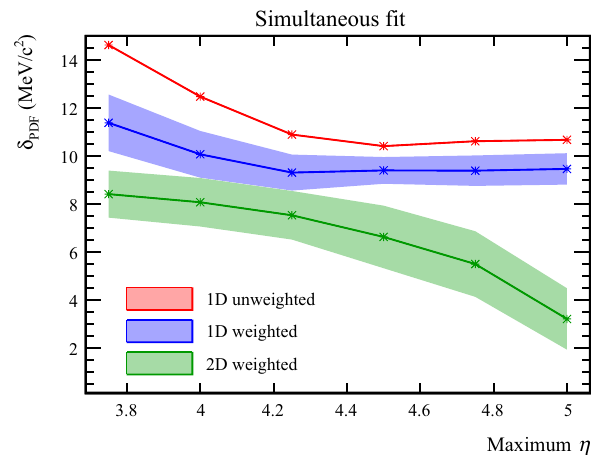
Fig. 15 PDF uncertainty as a function of the lower (left) and upper (right) η cut used in the simultaneous fit. The bands report the mean and the RMS of the distribution of the PDF uncertainty evaluated for